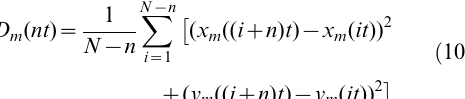
test populations. The null hypothesis is that the two test tions are considered continuous, but are otherwise not restricted.